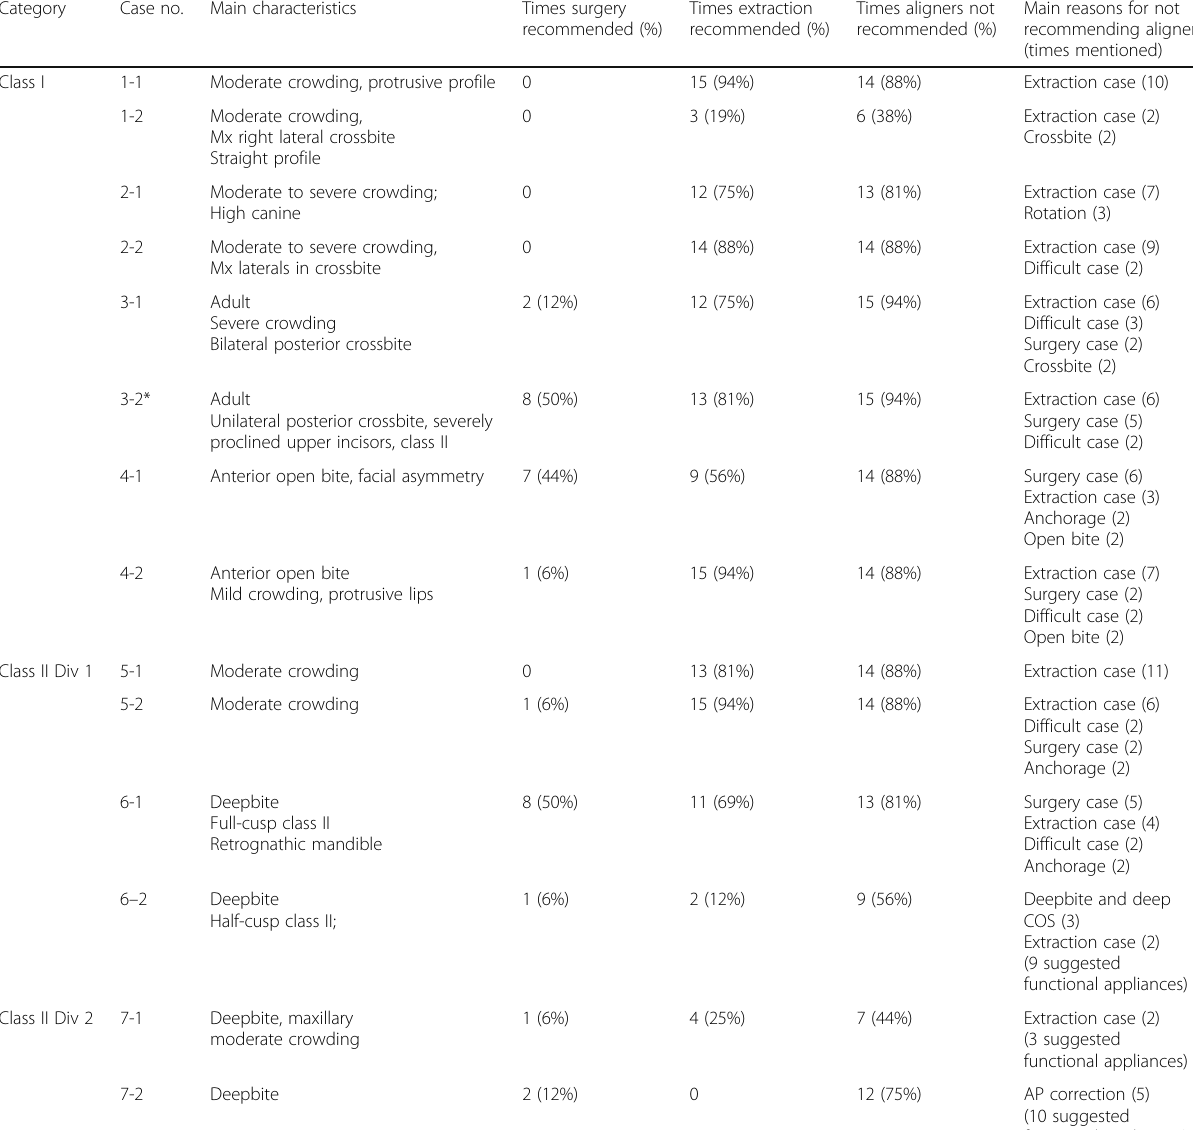
Table 5 Characteristics, treatment plans, and Invisalign® recommendations Category Case